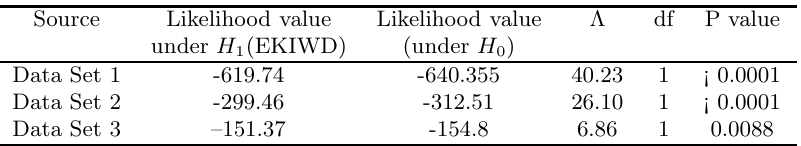
The values of log-likelihood functions and p values corresponding to the data set for testing H 0 : α = 1 against the alternative hypothesis H 1 : α 6 = 1 .